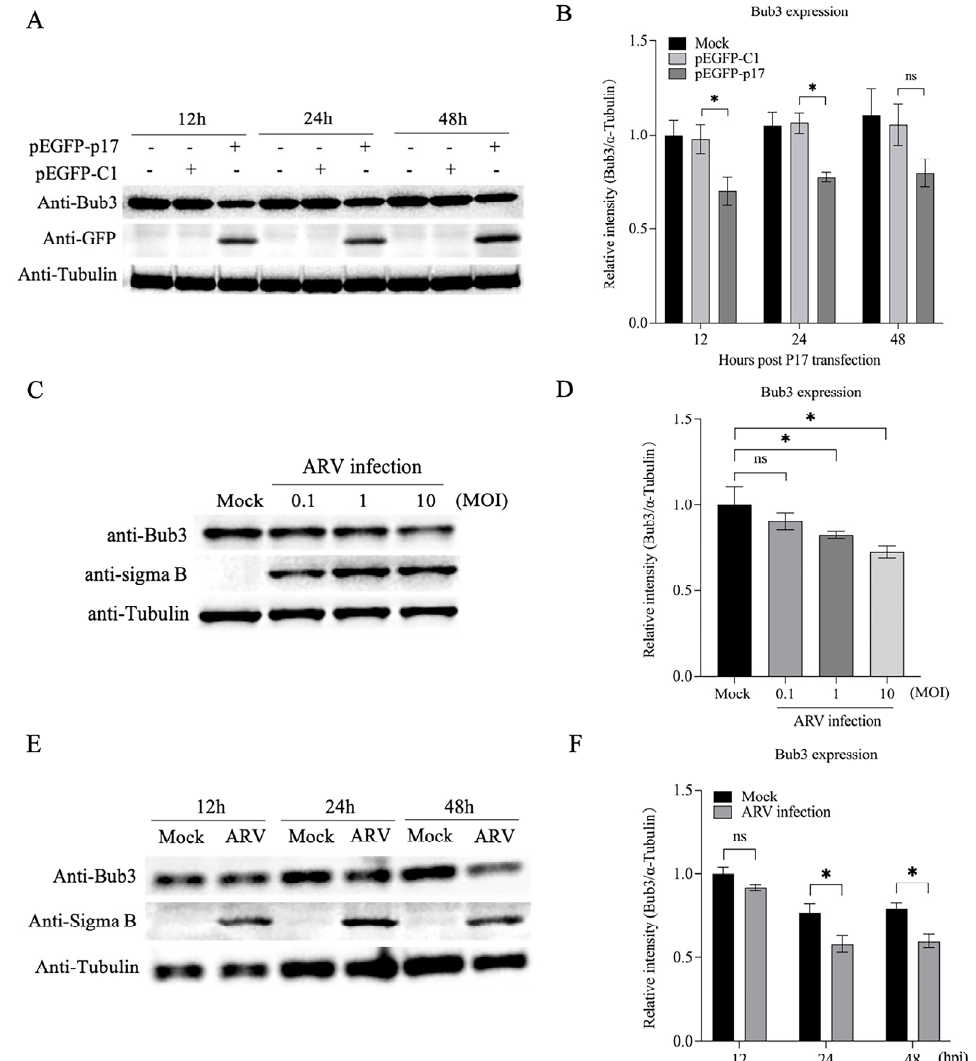
Figure 5. Both p17 overexpression and ARV infection result in a reduction in Bub3 in cells. ( A , B ) Overexpression of p17 decreased the Bub3 protein level. Vero-E6 cells were transfected with pEGFP-p17 or empty vectors, and cell lysates were examined by Western Blot using anti-GFP and anti-Bub3 antibodies at different time points (12 h, 24 h and 48 h) after transfection. The levels of Bub3 were normalized to that of α -Tubulin. ( C , D ) ARV infection suppressed the expression of endogenous Bub3. Vero-E6 cells were infected with ARV at different MOIs (0.1, 1 and 10). Twenty-four hours after infection, cell lysates were extracted and examined by Western Blot, and the levels of Bub3 were normalized to that of α -Tubulin. ( E , F ) Vero-E6 cells were infected with ARV at an MOI of 1. Cell lysates were extracted at different time points (12 h, 24 h and 48 h) post infection and examined by Western Blot. The levels of Bub3 were normalized to that of α -Tubulin. * stands for p < 0.05.